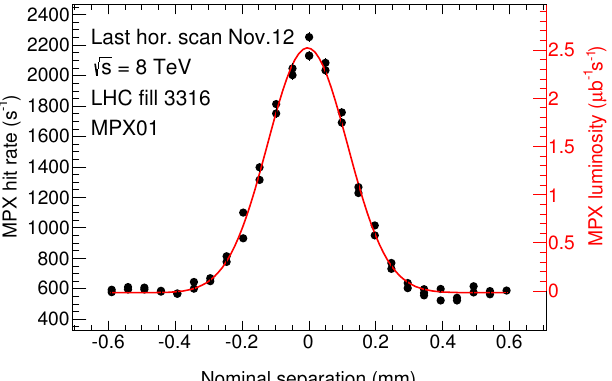
Figure 9. Luminosity from hit counting as a function of nominal beam separation measured with MPX01 during the last horizontal vdM scan of November 2012. Each data point shows the measured instantaneous luminosity before background subtraction and averaged over one acquisition time. Because the acquisition time is significantly shorter than the duration of a scan step, there can be more than one MPX sampling per scan step. The MPX samplings that partially or totally overlap with non-quiescent scan steps (varying beam separation) are not shown. The fit function is the sum of a single Gaussian (representing the proper luminosity in this scan) and a constant term that accounts for instrumental noise and single-beam background. The MPX normalization uses this horizontal and a vertical beam width from LHC vdM fill 3316. Taken from Ref. [11].